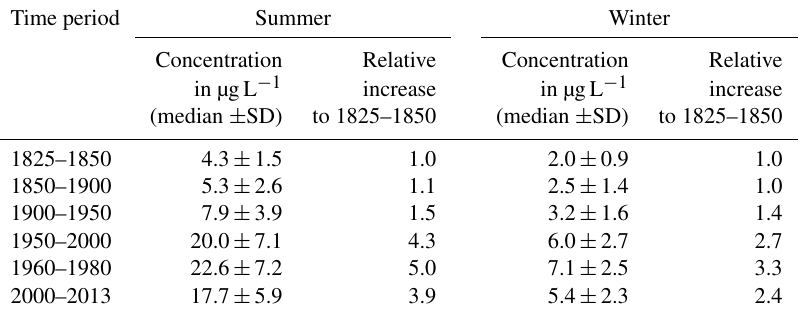
Table 1. rBC mass concentrations at seasonal resolution and relative increases compared to 1825–1850 (preindustrial era) for different time periods. Time period Summer Winter Concentration Relative Concentration Relative in µgL − 1 increase in µgL − 1 increase (median ± SD) to 1825–1850 (median ± SD) to